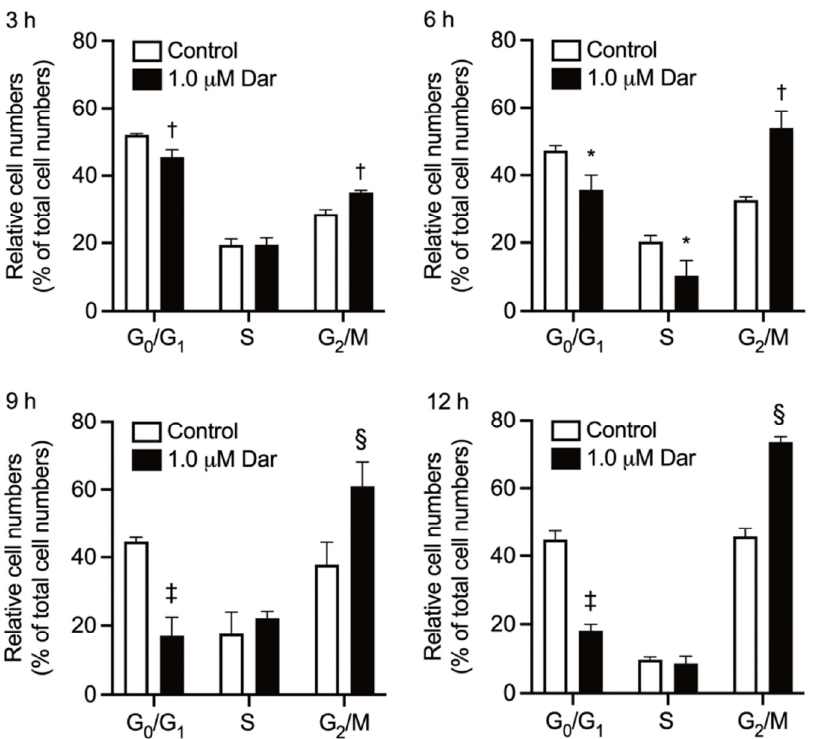
Figure 6. Effect of darinaparsin on cell cycle profiling in NB4 cells. Following treatment with 1 μ M darinaparsin for 3, 6, 9 and 12 h, cell cycle analysis was performed by CytoFLEX S flow cytometer as described in the “Materials and Methods” section. Quantifications of the percentages of cells at the G 0 /G 1 , S and G 2 /M phase fractions are shown. Results are shown as the means ± SD from three independent experiments. *, p < 0.05; †, p < 0.01; §, p < 0.001; ‡, p < 0.0001 vs. control. Dar, darinaparsin.